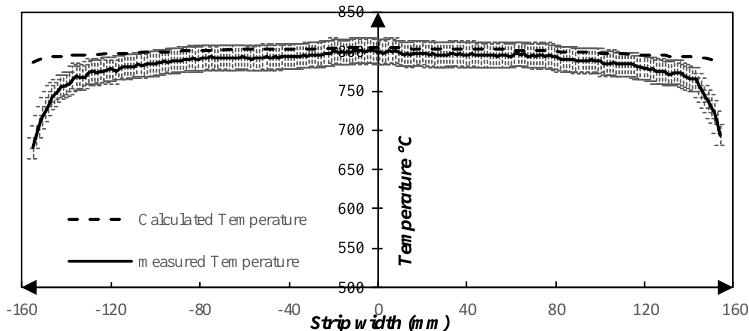
Figure 8. Comparison between the model and measured values in the transverse direction, line I–I in Figure 7b. Gas inlet position: surface A in Figure 2, Q = 2.66 Nm 3 /h, Strip velocity = v Strip (< 0.17 m/s) .